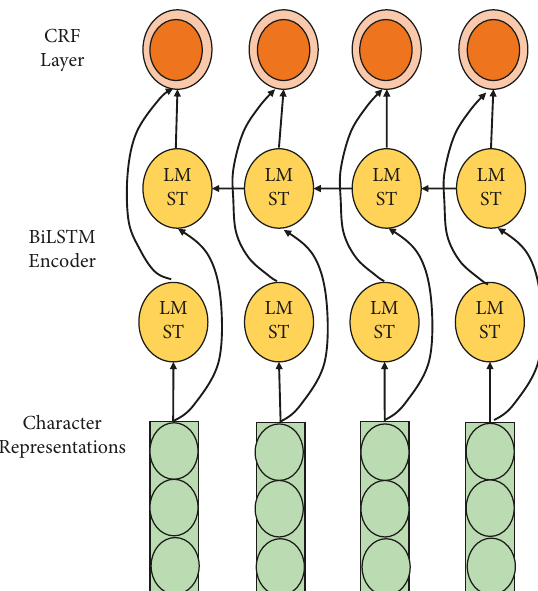
Figure 1: Schematic illustration of some knowledge graph